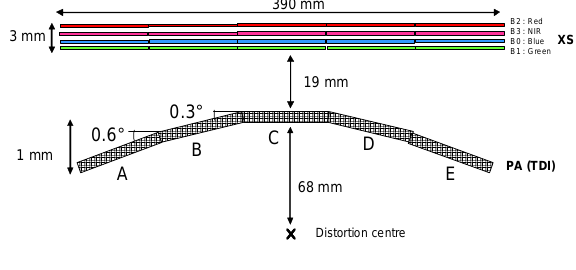
Figure 2. Pleiades-HR focal